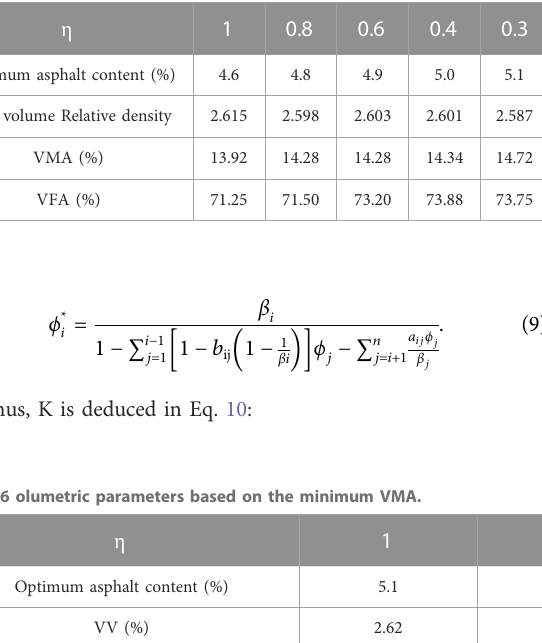
TABLE 5 Volumetric parameters based on a 4% air void.